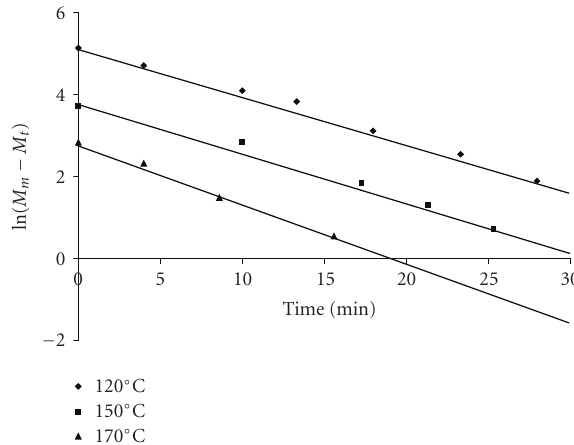
Figure 1: Plots of ln ( M m − M t ) versus time for mix M 2 at di ff erent